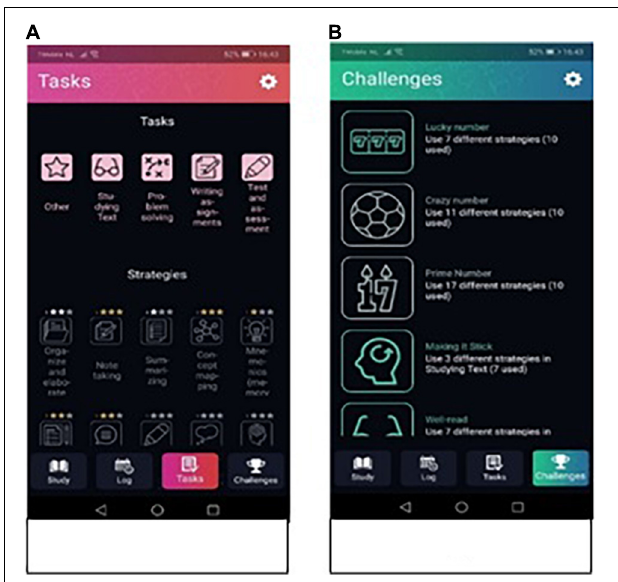
FIGURE 4 | Screenshots of gamification elements in app. Panel (A) shows the overview of the strategies with the level of use depicted in stars. Panel (B) shows the challenges students can take when using the